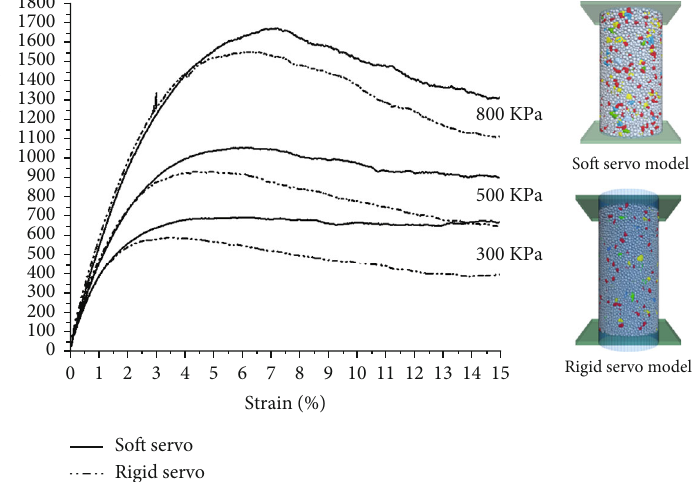
Figure 8: Comparison of soft and rigid servo e ff ects.